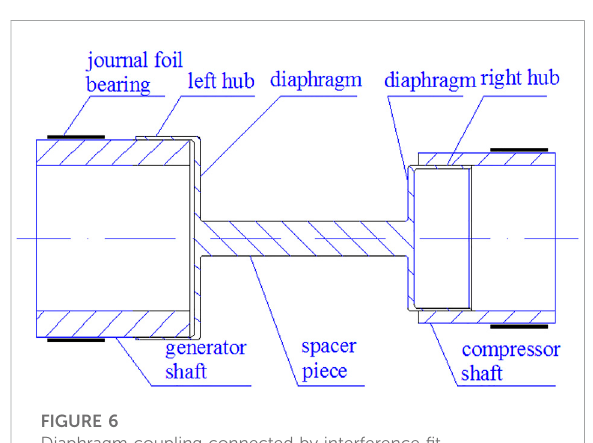
FIGURE 6 Diaphragm coupling connected by interference fi t.